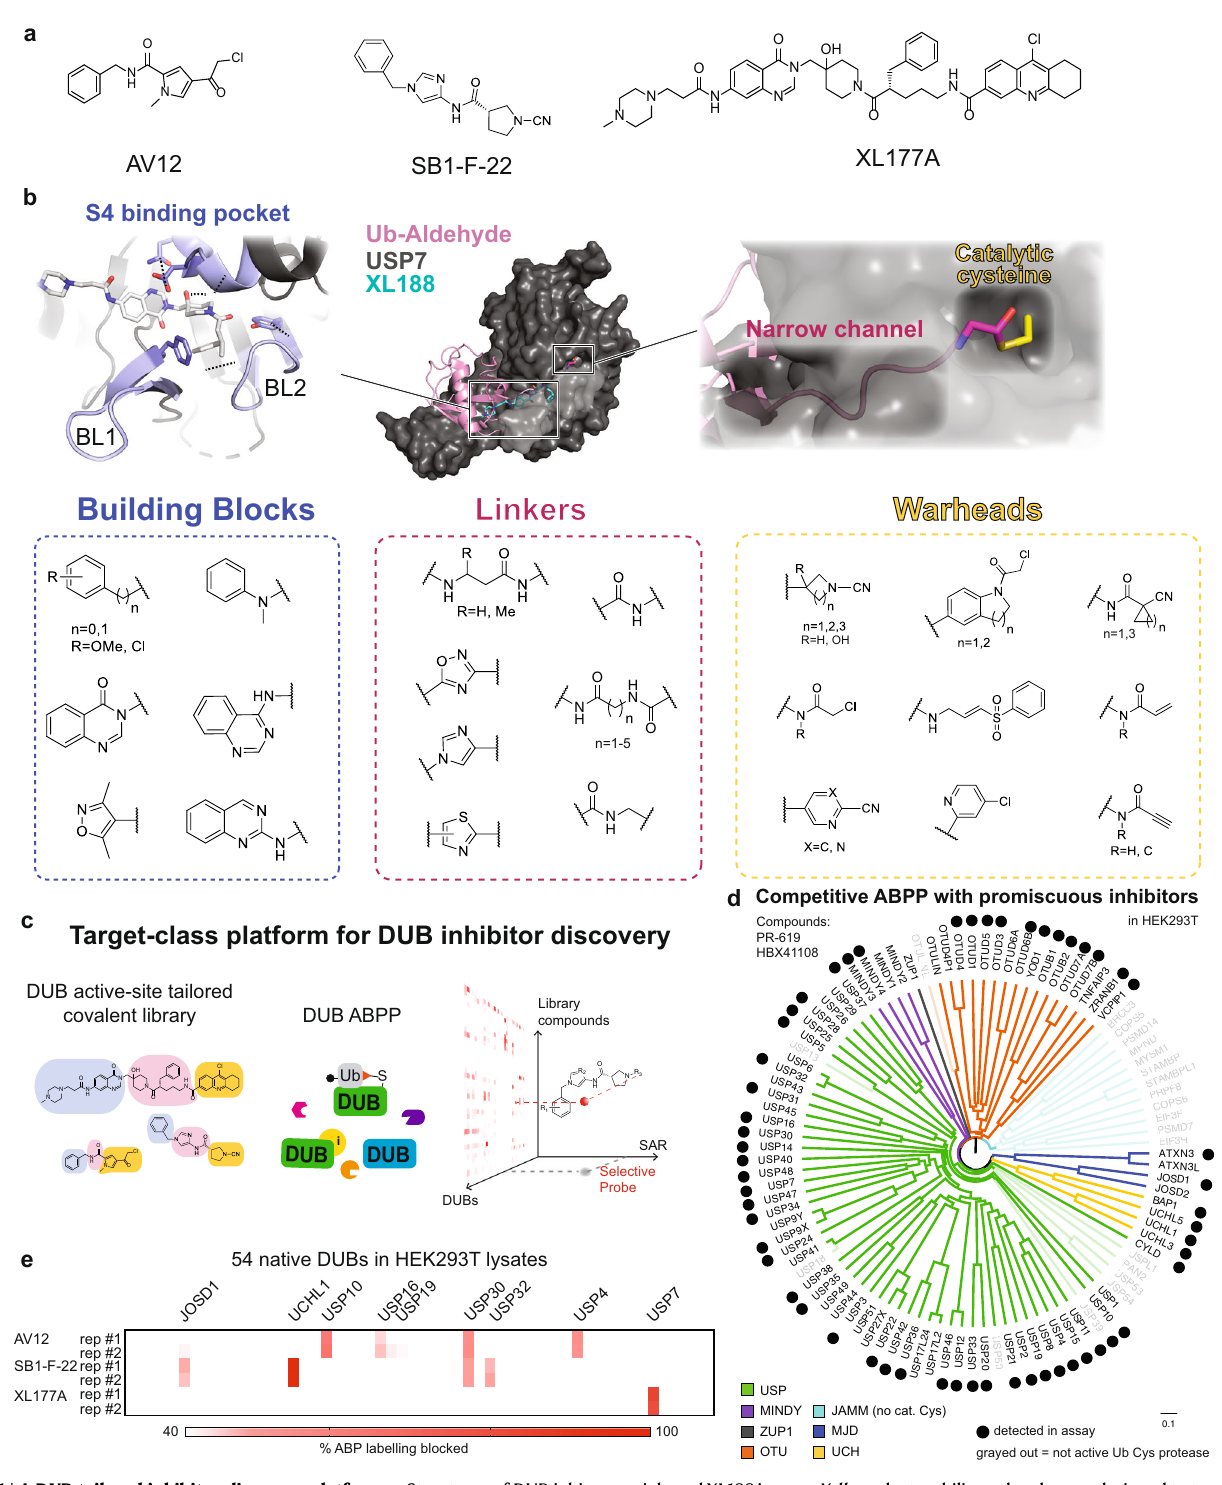
pink,andXL188incyan. Yellow :electrophilicwarheadsweredesignedtotargetthe invariant catalytic cysteine residue shown in yellow in the top panel. c The target- class platform yields high content data to drive DUB hit identi fi cation and SAR for compound optimization. d Analysis of multitargeted covalent DUB inhibitors (HBX41108and PR619) con fi rmedthatour DUB-ABPP platformspanned members from all subfamilies of cysteine protease DUBs 3,4 . The dendrogram is colored by DUB subfamily. e ABPP analysis using covalent inhibitors depicted in ( a ) in dupli- cateruns(eachshownindividually)validatedtheabilityofourplatformtoread-out selective compound binding activity with deep coverage of the human